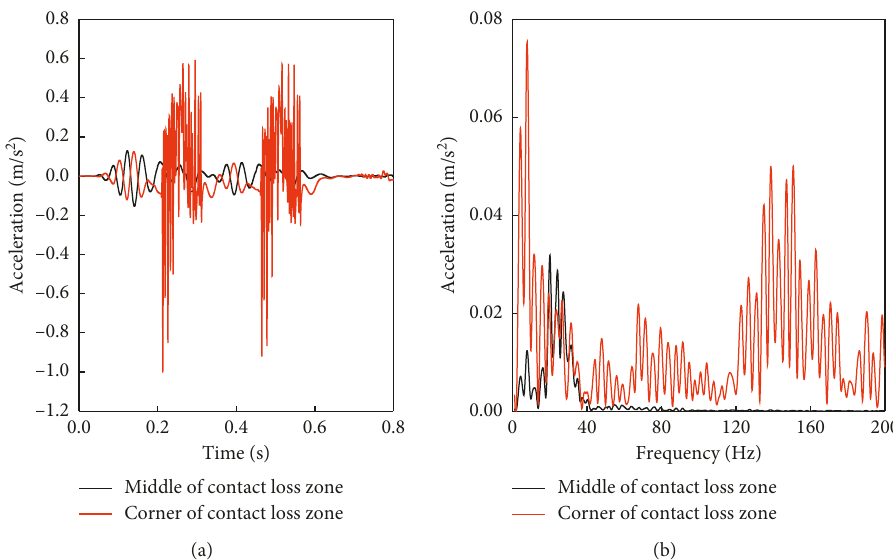
Figure 13: Time-frequency analysis of vibration acceleration at different positions of contact loss zone on the roadbed surface: (a) time domain and (b) frequency